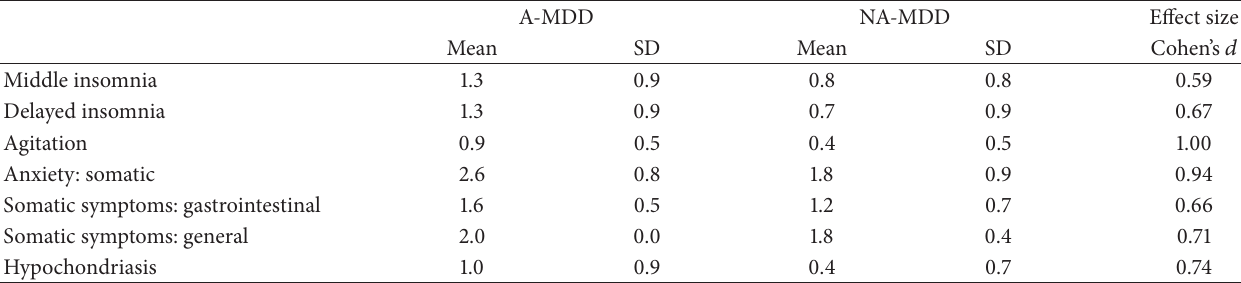
Table 2: Medium and large effect size differences between A-MDD and NA-MDD groups on the 17-item HAM-D.